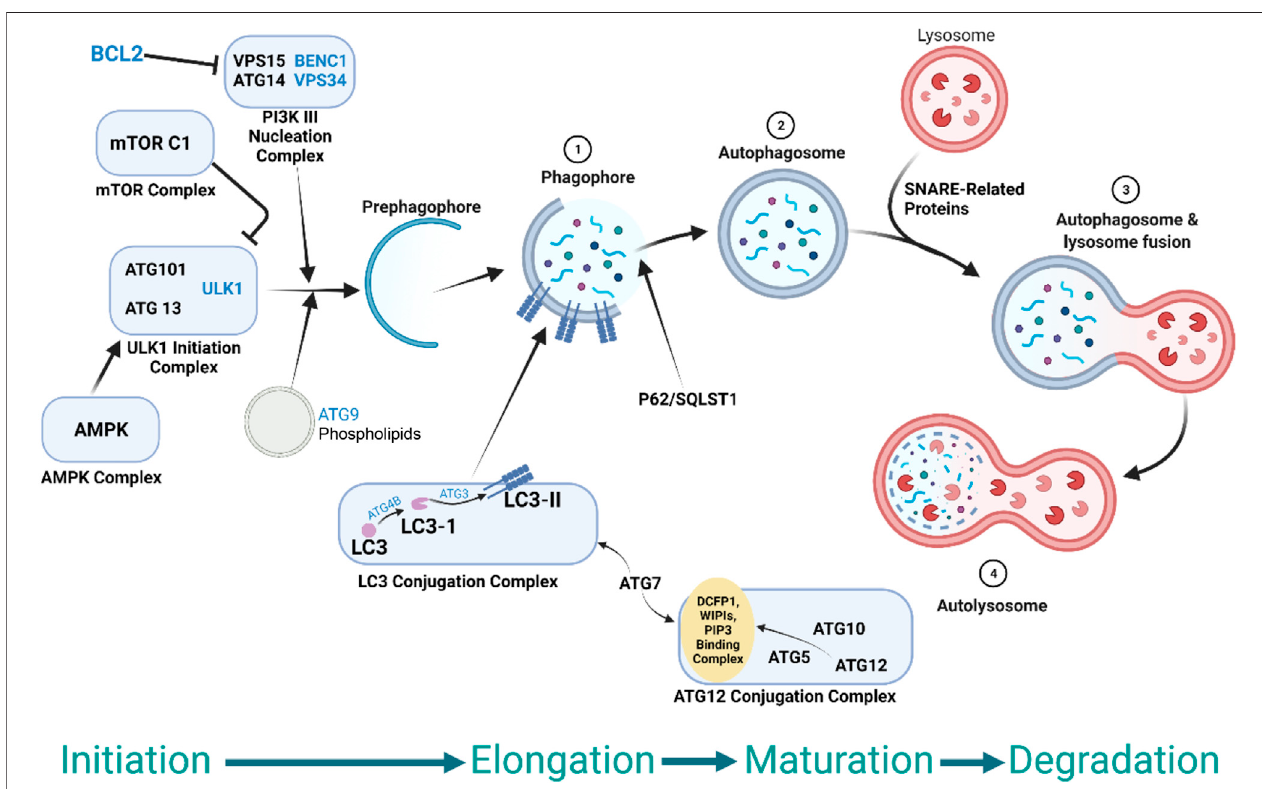
FIGURE 1 | Schematic depiction of the autophagy pathway and its regulation by various signaling molecules, autophagosomes, and lysosomes in cell biology. Autophagosome formation is a complex process that involves several phases: Autophagosome initiation which involves ULK1 complex and the class III phosphatidylinositol3-kinase(PI3K)complexandotherproteincomplexes.Theelongationstepinvolvestheactionoftwoubiquitin-likeconjugationsystemsandrequires the conjugation ofLC3tothephosphatidylethanolamine,aform called LC3-II,allowing theexpansionoftheinitialmembraneand con fi ning aportion ofthecytosol. The maturation and degradation step involve autophagosome closure, the fusion of the autophagosome with the lysosome to form the autolysosome, and degradation step mediated by lysosomal enzymes which degrade the proteins and other substrates in the autolysosome. More information on autophagosomes and autophagy process can be found in the literature (Reggiori and Ungermann,